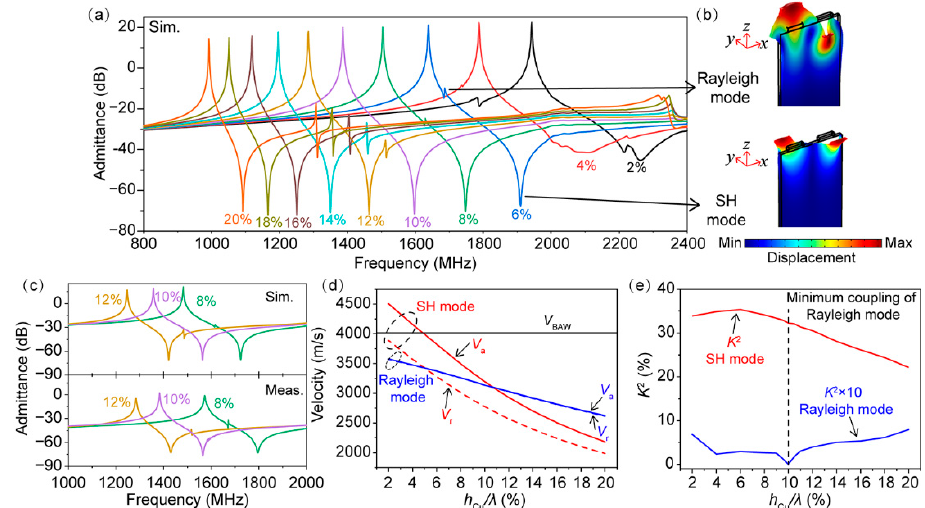
Figure 1. ( a ) The simulated admittance curves at different normalized thicknesses h Cu / λ on 15°YX-LiNbO 3 substrate; ( b ) displacement field of Rayleigh and SH modes; ( c ) the simulated and measured admittance curves at normalized thicknesses h Cu / λ of 8%, 10% and 12%; ( d , e ) velocities and electromechanical coupling coefficients of two modes extracted from the simulated admittance curves.